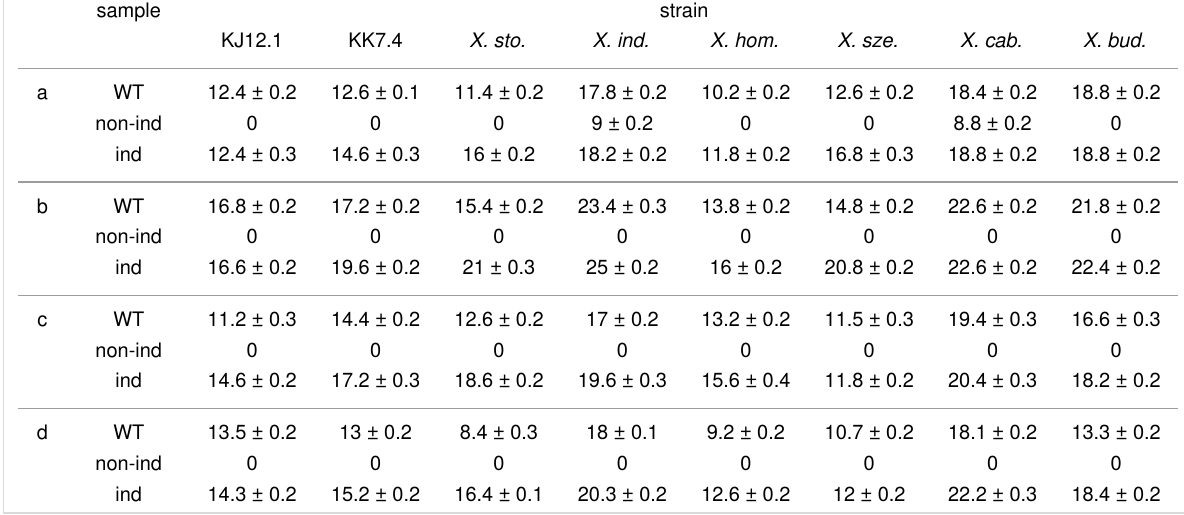
Table 3: Inhibition zones of the wild type (WT) and promoter-exchange mutant strains (non-ind: non-induced, ind: induced) in mm against the human pathogens Escherichia coli (a, ATCC 25922), Staphylococcus aureus (b, ATCC 29213), Enterococcus faecalis (c, ATCC 29212), and Klebsiella pneu-